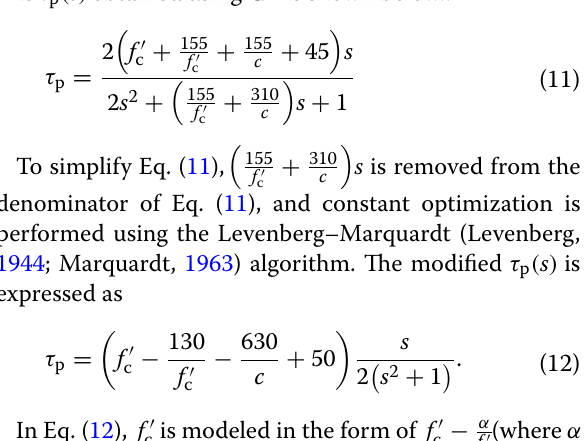
* τ p : Bond–slip function for pull-out